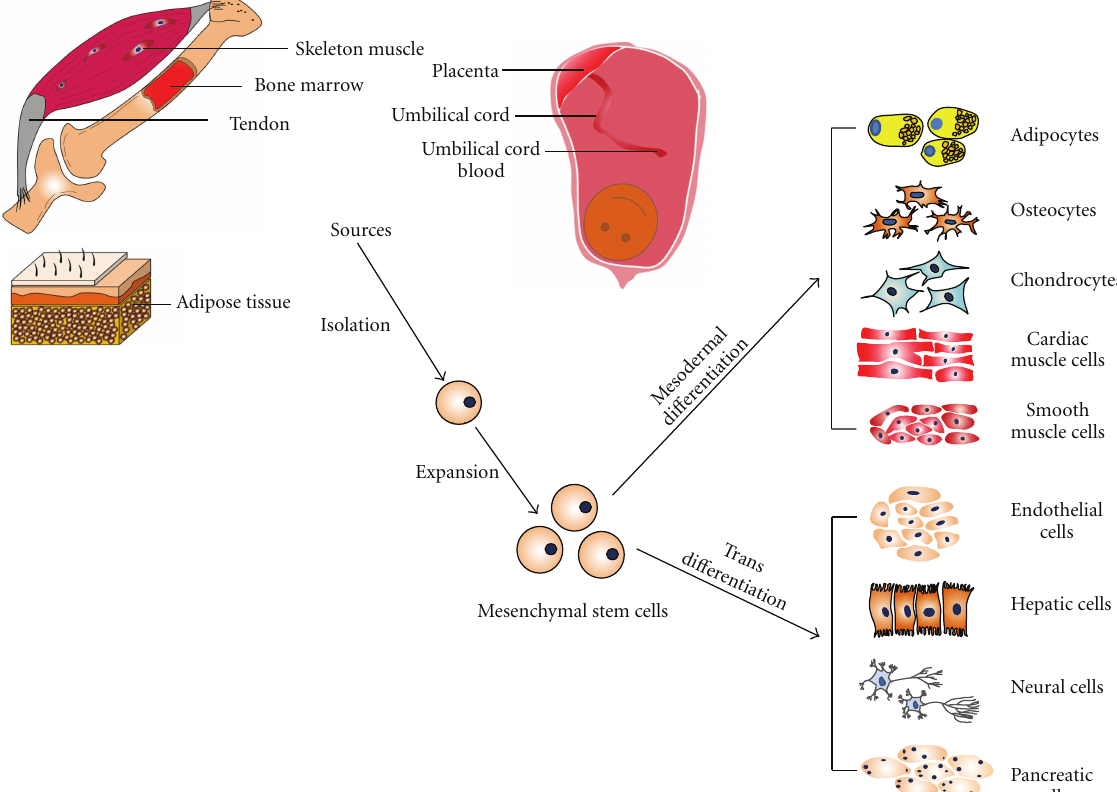
Figure 1: Multipotent Di ff erentiation of Mesenchymal Stem Cells from Di ff erent Sources. MSCs can be obtained from skeleton muscle, bone marrow, tendon, adipose tissue, placenta, umbilical cord, and umbilical cord blood. MSCs have the potential to generate mesodermal lineages such as adipocytes, osteoblasts, and chondrocytes; on the other hand, they can also trans-di ff erentiate into some cells lineages from other germ layers such as adipocytes, osteocytes, chondrocytes, cardiac muscle cells smooth muscle cells, and endothelial cells form mesodermal layer, neural cells from ectodermal layer, and hepatic cells and pancreatic cells from endodermal